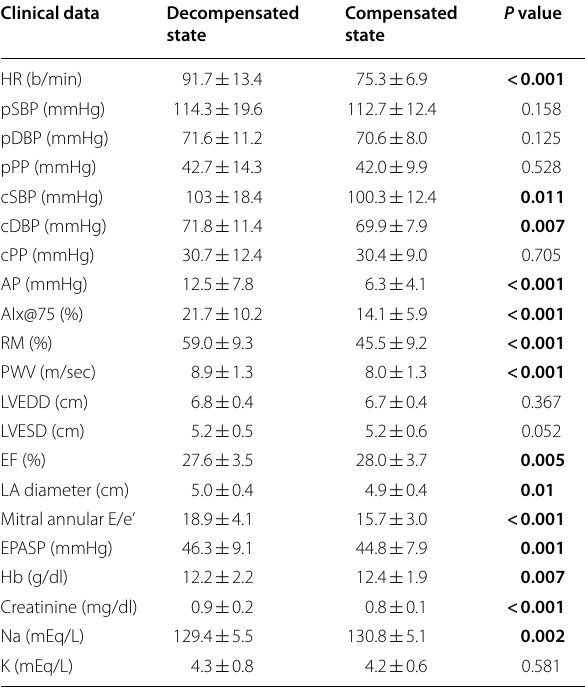
Table 2 Comparison of the clinical data of all patients during the decompensated and compensated states